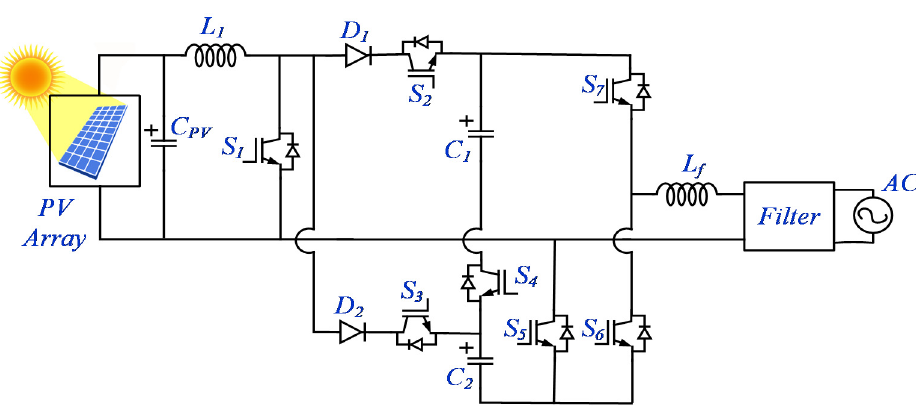
Figure 10. Boost converter and transformerless half-bridge inverter.